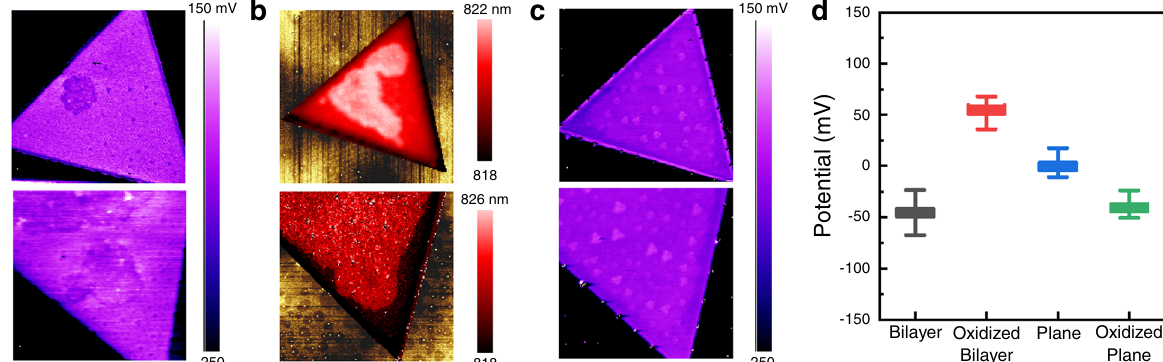
Fig. 4 Tracking oxidation in monolayer MoSe 2 . a Potential map of two fl akes at 0 months, b PL wavelength map at 3 months, and c potential map at 6 months. Scale bars are 4 μ m. d Relative potential value of MoSe 2 fl ake. The values are normalized to that of the unoxidized basal